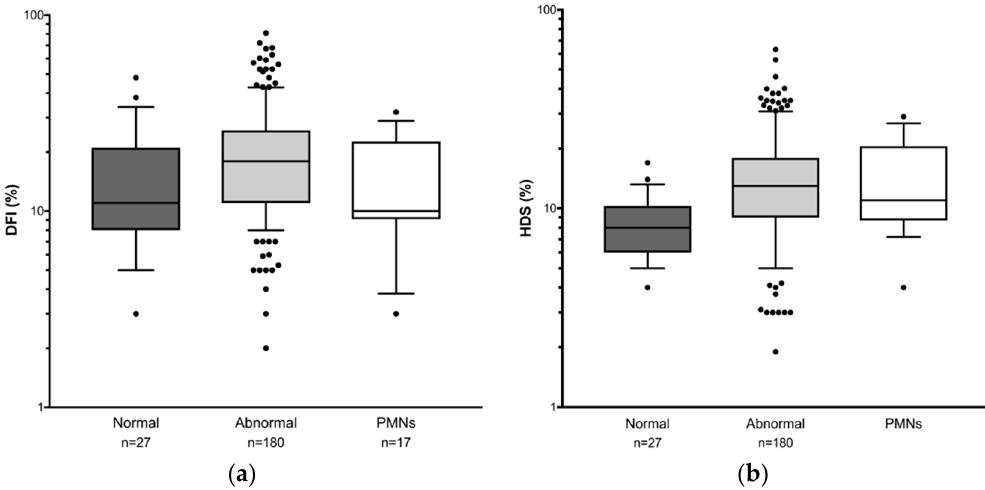
Figure 2. Box and whisker plots for sperm genetic integrity in different patient groups showing the median and interquartile ranges. Normal—normal semen parameters; Abnormal—abnormal parameters with <1 million/mL leukocytes; PMN—any parameters with ≥ 1 million/mL leukocytes. Sperm DNA fragmentation and HDS were assessed in the same samples. ( a ) DNA fragmentation (DFI) ( b ) immature chromatin (HDS). Lower whisker = 10th percentile; upper whisker = 90th percentile. Dots indicate values outside the range. Data are shown on a logarithmic scale.